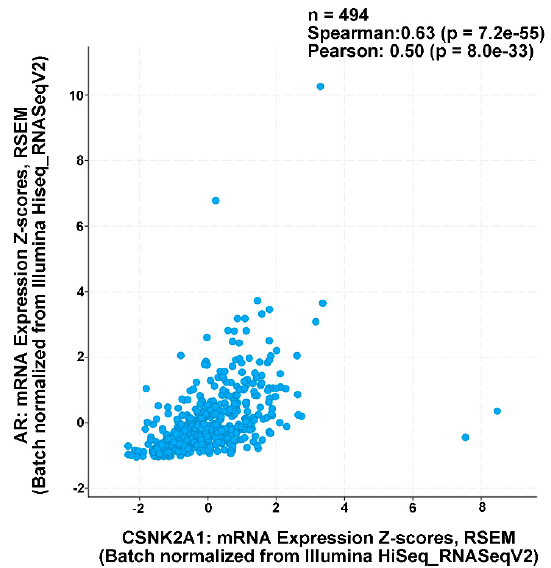
Figure 2. Co-expression of CSNK2A1 and AR genes in prostate cancer patient primary tumor samples. Analysis of co-expression of CSNK2A1 and AR mRNA levels in PCa patient samples from The Cancer Genome Atlas (Pan-Cancer Atlas; n = 494 samples). Correlation analysis and p-values provided within panel. Analysis performed using cBioPortal with Z-score cut-off set at 1.5. RSEM, RNA-Seq by Expectation–Maximization.